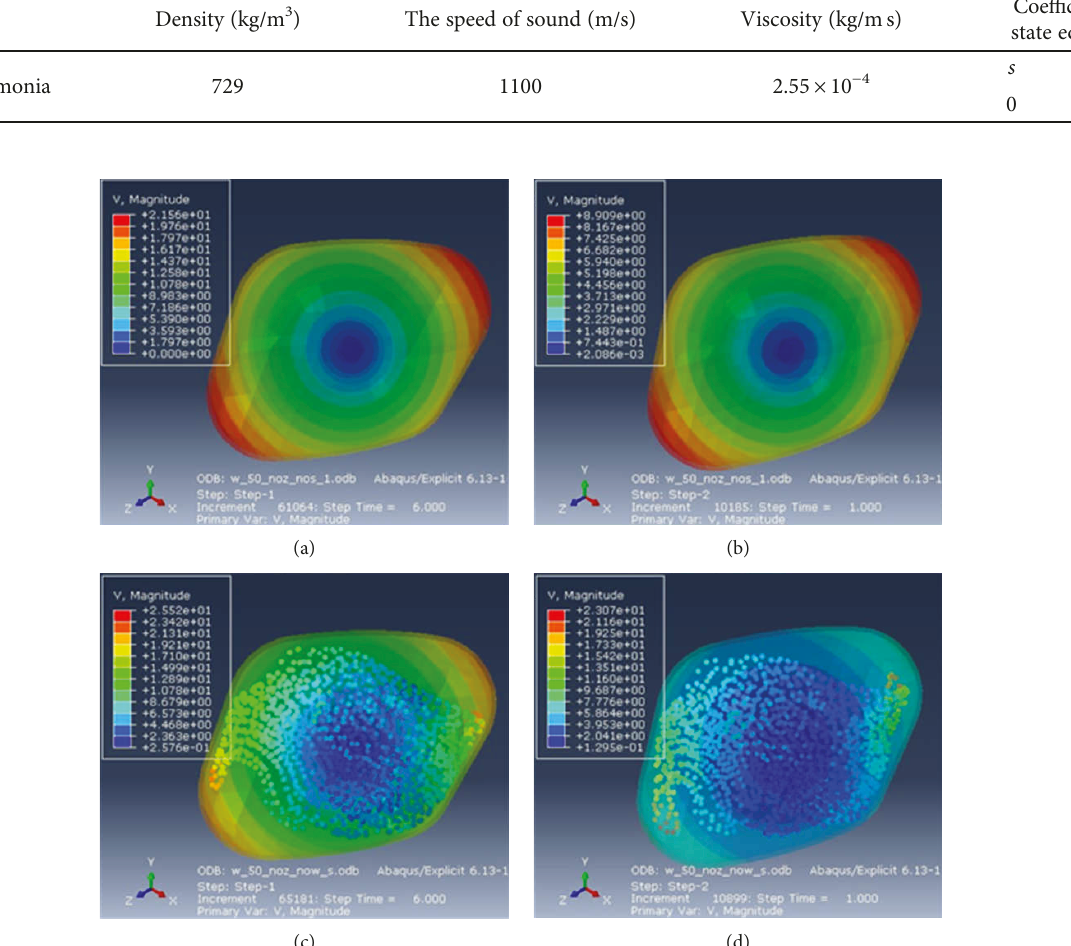
Figure 5: Moving speed of the storage tank and liquid: (a) the empty storage tank after 6s; (b) the empty storage tank after 7s; (c) the liquid storage tank after 6s; (d) the liquid storage tank after 7s.